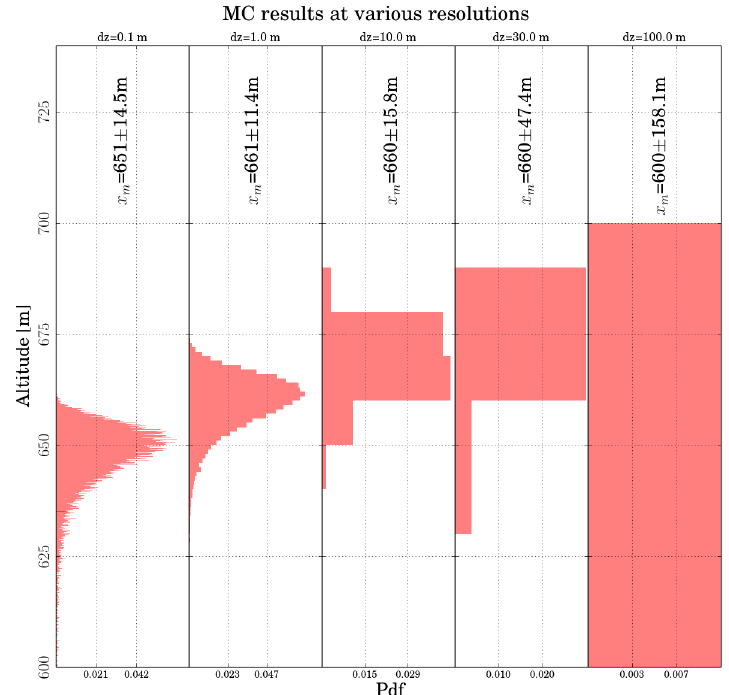
Figure 6. Probability density functions of five MCs performed 100000 times each. From left to right we created θ s (z) with the following resolutions: d z = 0 . 1, 1, 10, 30, and 100m. On each plot, the median of the distribution x m and its localization error as defined in Eq. (7) are